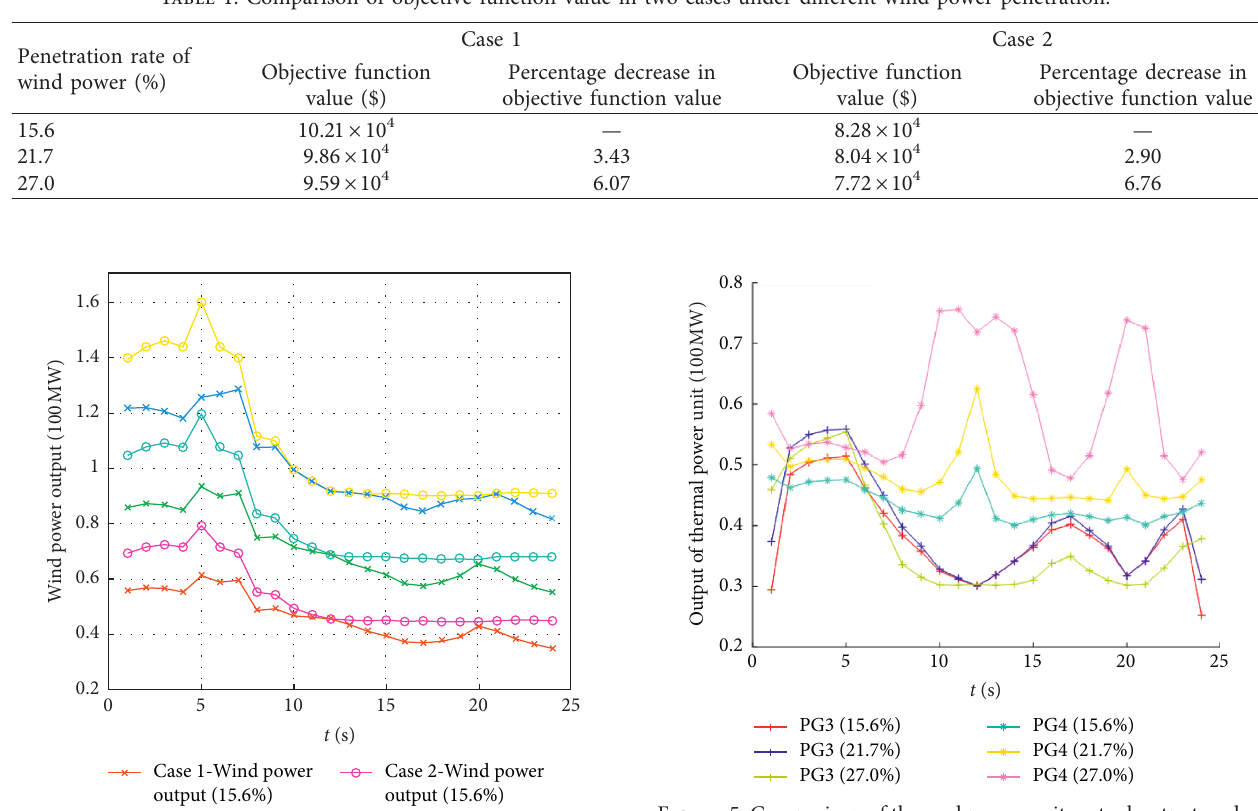
Figure 5: Comparison of thermal power units actual output under different wind penetration rates in Case 1.